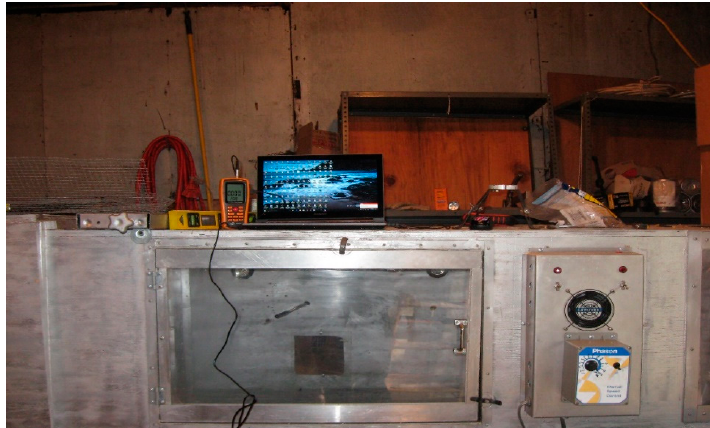
Figure 2. Setup for the calibration of the fan air flow in terms of m/s.